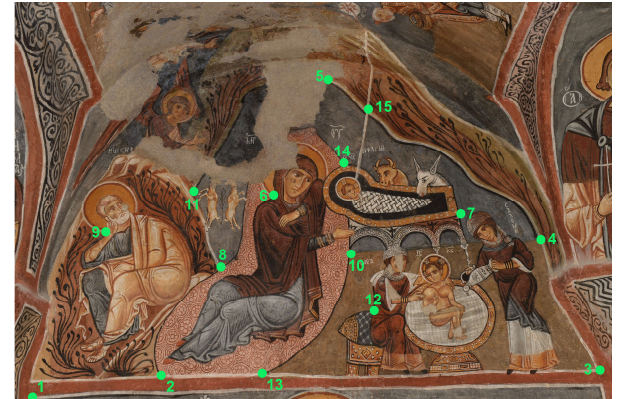
Figure 7. Feature points manually chosen for the Karanlık church.